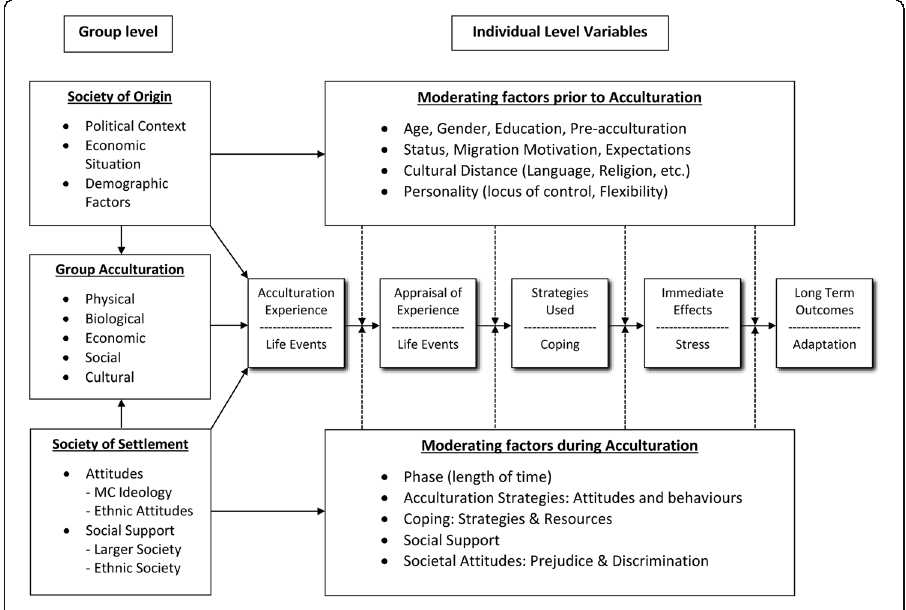
Fig. 1 Berry ’ s framework for research on acculturation (1997). Source: Berry 1997, p.